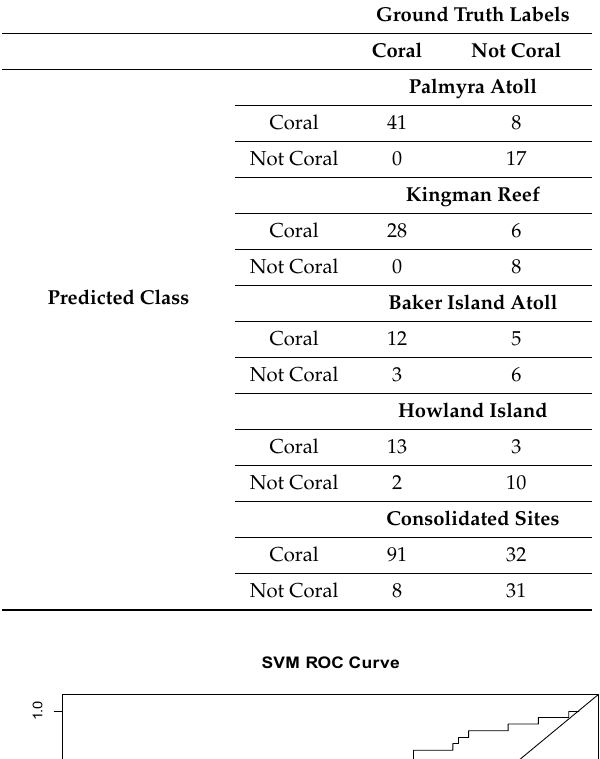
Table 4. Confusion matrix by site and the consolidated sodel.